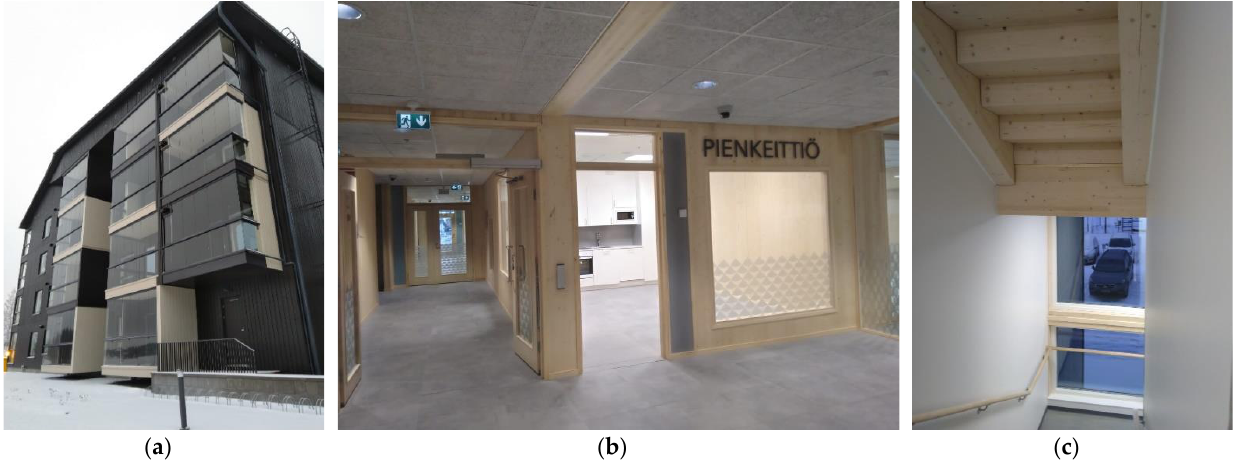
Figure 9. As Oy Tampereen Niemenrannan Rantapuisto—Raamikatu 32, Niemenranta: ( a ) exterior view; ( b , c ) interior views (photos courtesy of Suomen